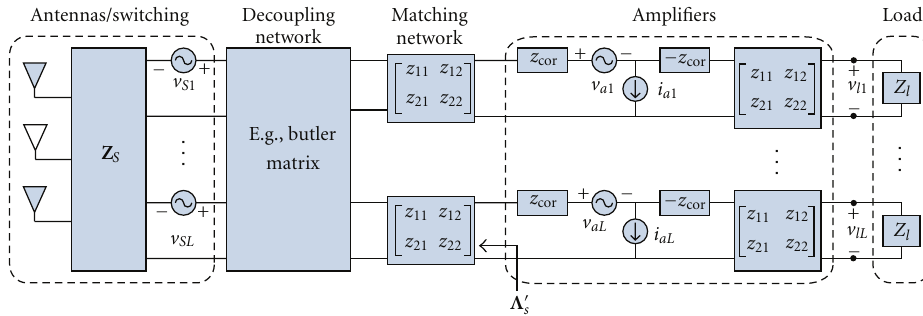
Figure 4: A circuit model of a circular array receiver with antenna selection and mutual coupling.